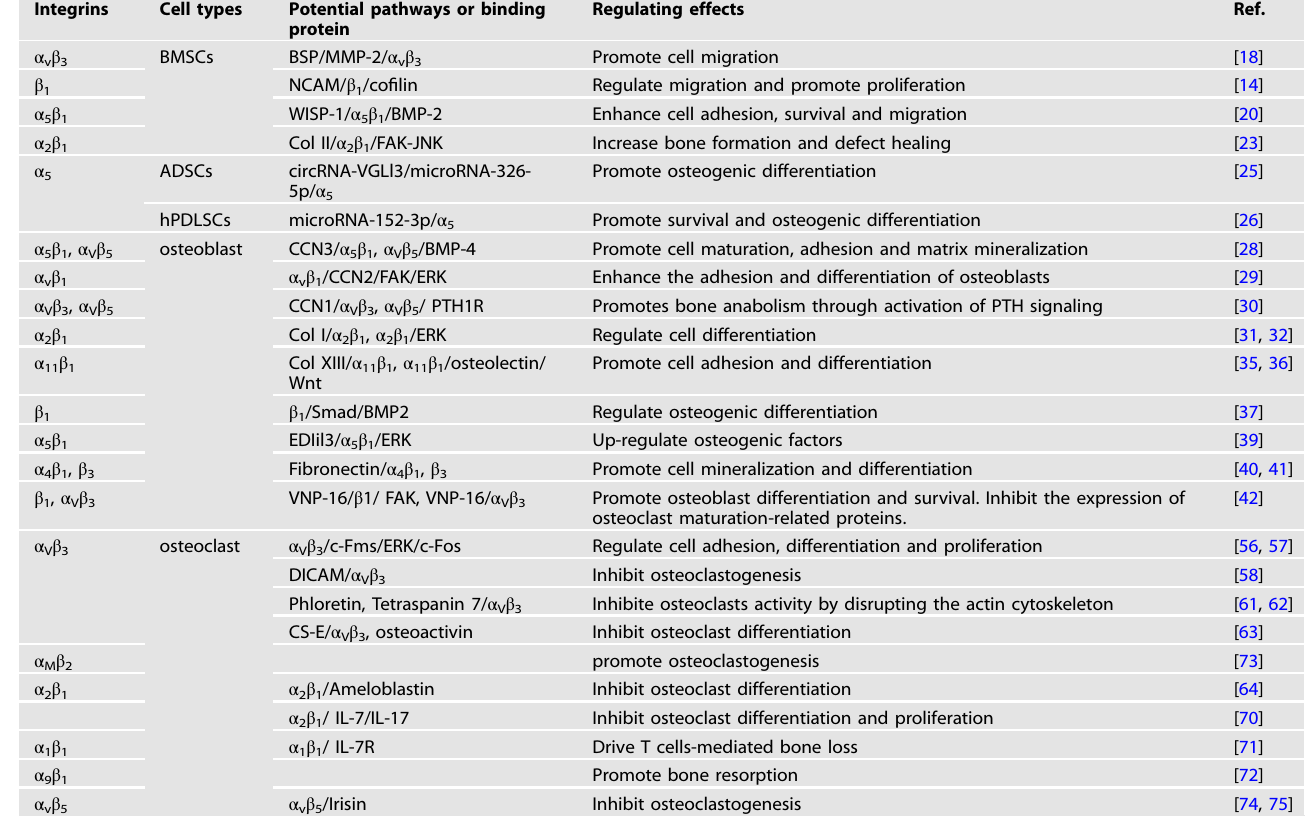
Table 1. The role of integrins in bone metabolism at different cellular stages. Integrins Cell